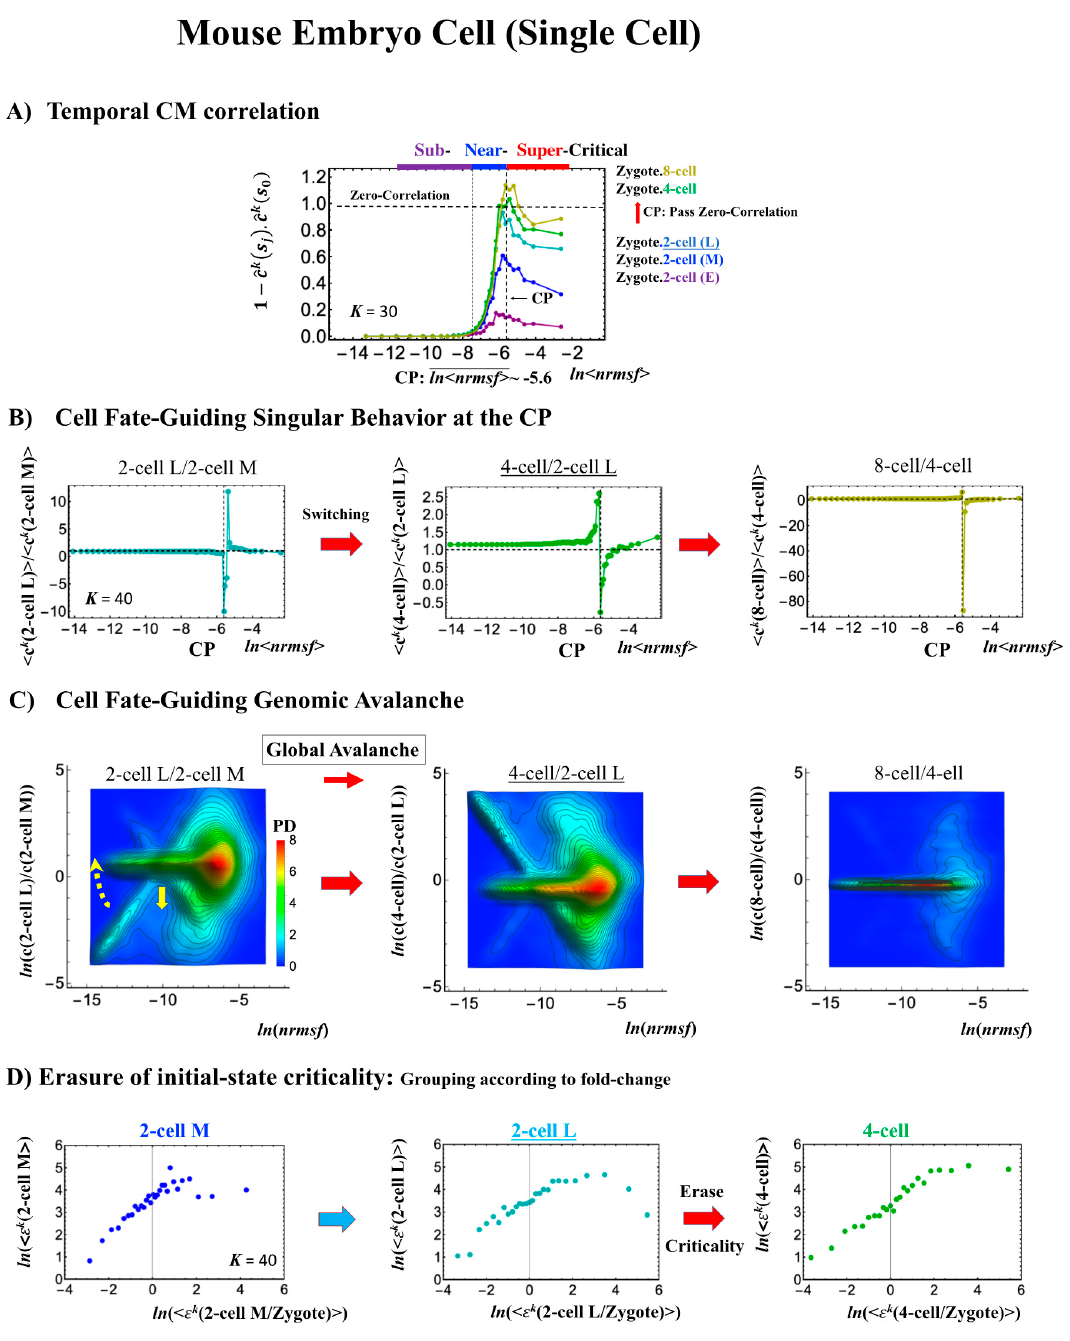
Figure 8. Mouse embryonic development (single-cell). Complete erasure of the zygote-CP ( K = 30: n = 571 RNAs) occurs after the late 2-cell state ( B ) through the switching singular transition at the CP ( K = 40: n = 428 RNAs). ( C ) A cell fate-guiding genome avalanche occurs from the middle 2-cell (2-cell M) to 4-cell states through the late 2-cell state (2-cell L), where the whole-genome PDF shifts from up- to downregulation and the scaling behavior ( ln ( nrmsf ) < − 11) reflects along the zero-fold change ( y = 0) to exhibit a coherent switching of folding and unfolding chromatin dynamics (see yellow solid and dashed arrows, respectively). The PDF shows that the CP is ON at the middle 2-cell – late 2-cell state, and OFF at the late 2-cell – 4-cell state and at the 4-cell state – 8-cell state. ( D ) Erasure of initial sandpile criticality occurs after the late 2-cell state, coinciding with the result of ( A ) and confirming the timing of the cell-fate change (after the late 2-cell state). Note: A traveling wave is also observed as seen in the human embryo cell (Figure 7C) between the zygote and other states.